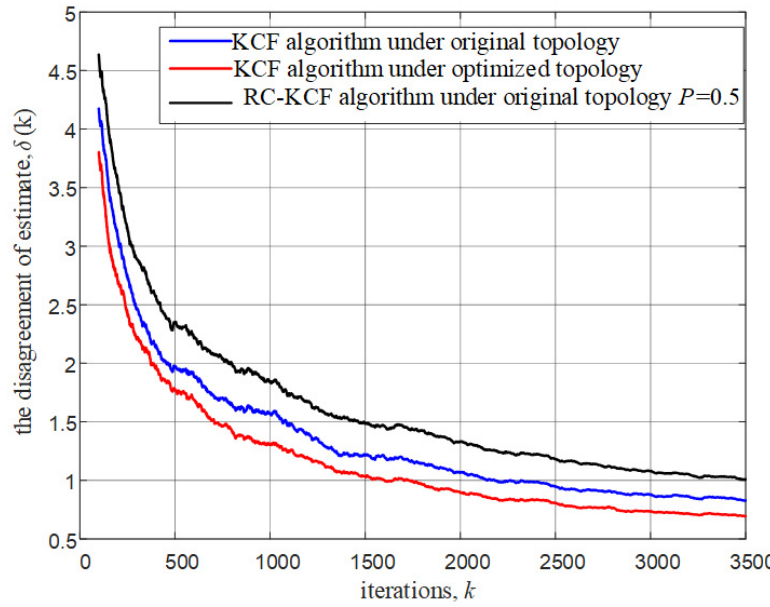
Figure 7. The mean square estimate